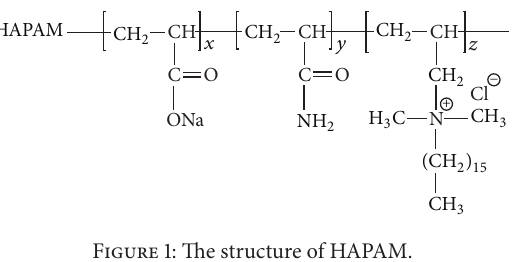
Figure 1: The structure of HAPAM. Table 1: Composition of the simulated injection water.